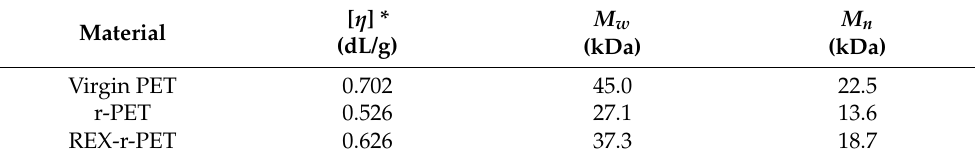
Table 1. Intrinsic viscosity values of the PET samples.